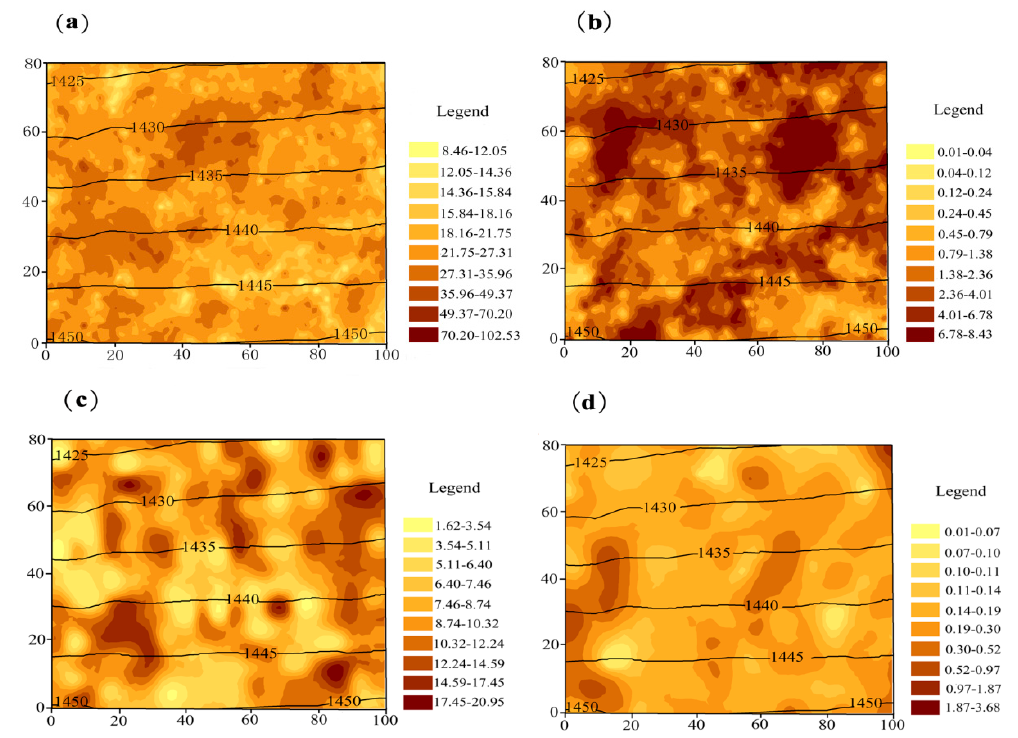
Figure 4. Spatial distribution of biomass C (kg per plant) in Pinshuo opencast coal mine, China. Black lines denote contours marked with elevation values (m ASL). Axis scale is in meters. ( a ) Planted R. pseudoacacia ; ( b ) seeded-in R. pseudoacacia ; ( c ) P. tabuliformis ; ( d ) U. pumila .